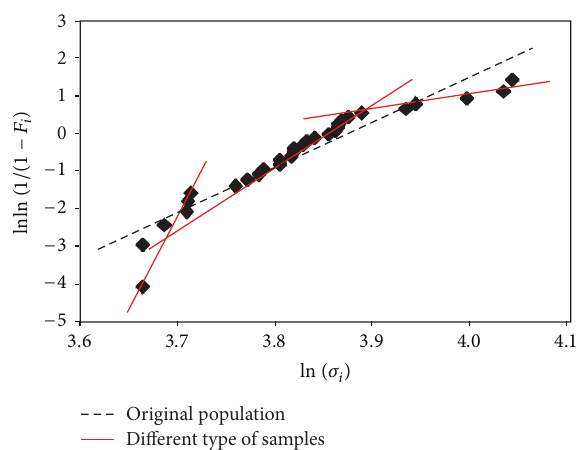
Figure3:TheWeibullplotofstrengthofVitaVMK68polishedwith 100-grit. The dashed line indicates the original population, and solid lines indicate volume and surface flaw populations.